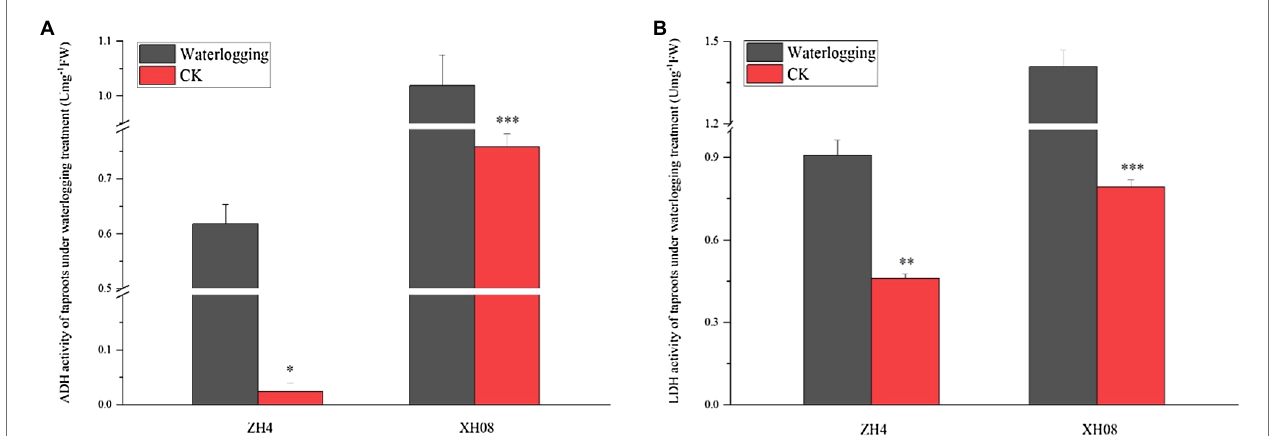
FIGURE 9 | The difference in the activities of ADH and LDH (U mg − 1 FW) in two different peanut cultivars after 12 days of waterlogging treatment. (A) The difference in ADH activity (U mg − 1 FW) between ZH4 and XH08 after 12 days of waterlogging treatment. (B) The difference in LDH activity after 12 days of waterlogging treatment between ZH4 and XH08 ( * p < 0.05; ** p < 0.01; *** p <